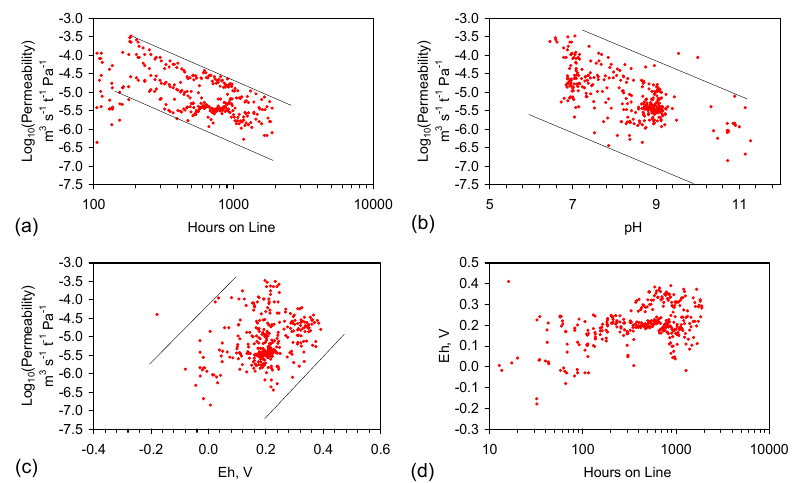
Figure C4. ZVI permeability decline as a function of: ( a ) time; ( b ) pH of the water leaving the ZVI column; ( c ) Eh of the water leaving the ZVI column; ( d ) Eh vs. time. Further details of the ZVI, flow apparatus and testing procedures are provided in References [16,17,38]. Data Source: [17].